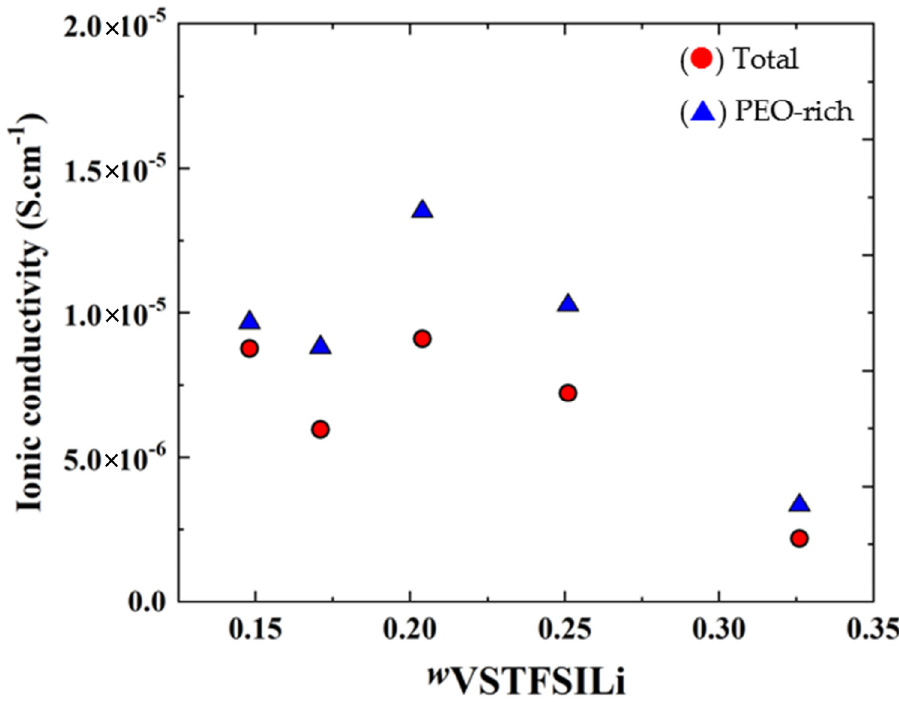
◦ Figure 10. Isothermal variations at 60 °C of the (  ) total conductivity σ t containing PEO-rich phase Figure 10. Isothermal variations at 60 C of the ( • ) total conductivity σ t containing PEO‑rich phase with TFSI-rich domains and (  ) PEO-rich phase σ PEO , as a function of w VSTFSILi . with TFSI‑rich domains and ( ▲ ) PEO‑rich phase σ PEO , as a function of w VSTFSILi Finally, the cationic transference number ( t + ) was determined at 80 °C for each HySI